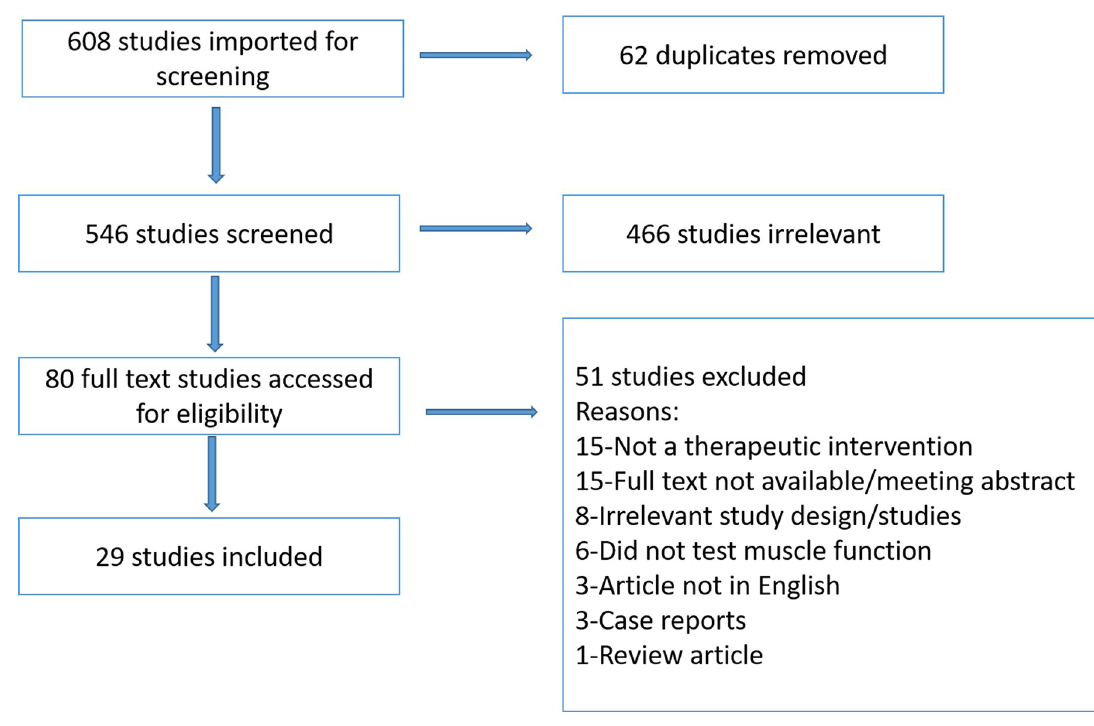
Fig 1. Prisma flow